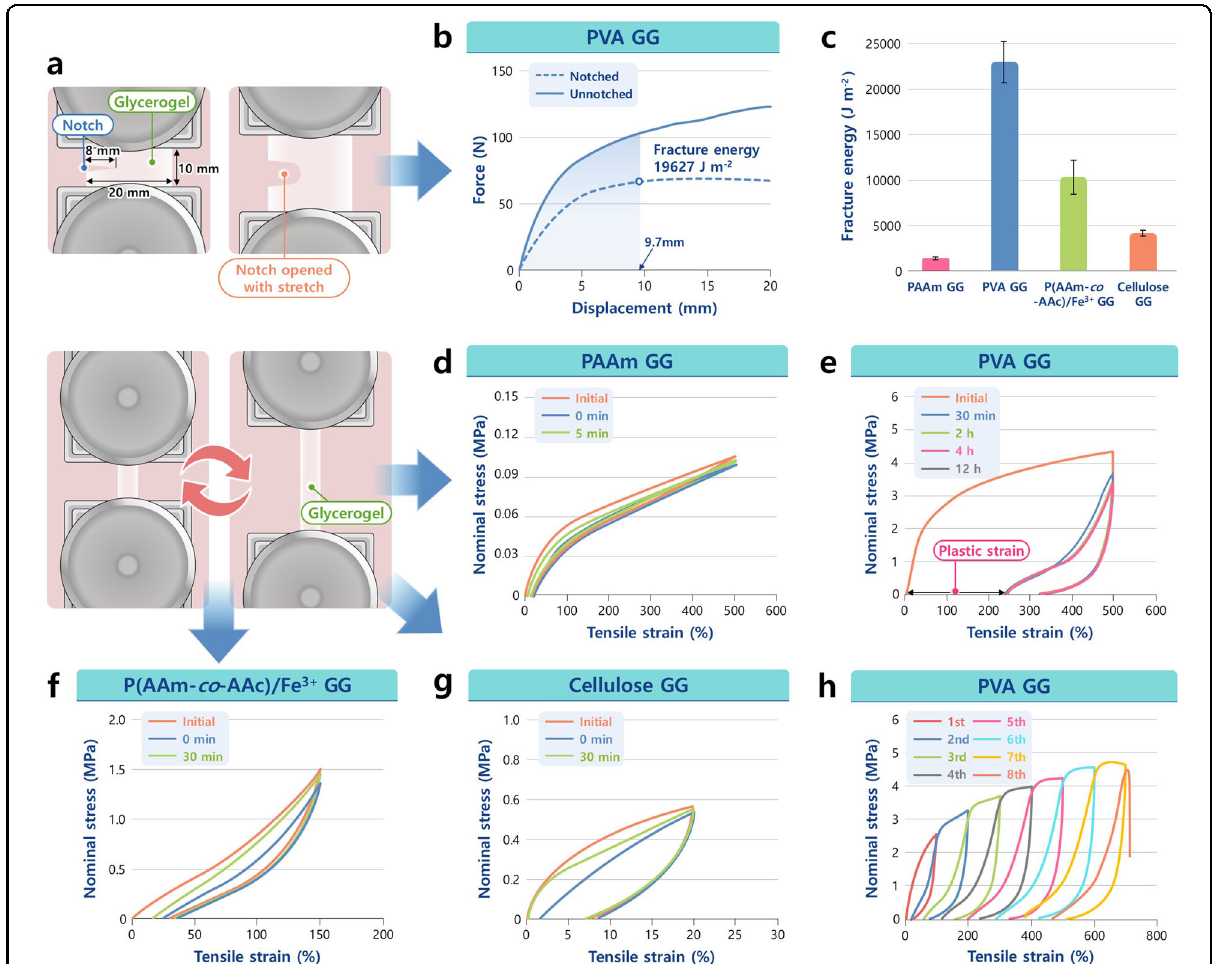
Fig. 4 Fracture toughness, hysteresis, elasticity, and plasticity of the GGs. a Demonstration of the tensile fracture test of the notched sample for the determination of fracture energy. b Force vs. displacement curves of the notched and unnotched samples of PVA GG. The critical displacement ( L c ) at which cracks begin propagating through the notched sample (detected by video analyses) is identi fi ed by the open circle. The fracture energy is determined by dividing the work done ( fi lled area) to stretch the unnotched sample to L c by the cross-sectional area of the sample. c Determined fracture energies of different GGs. Tensile loading – unloading curves of ( d ) PAAm GG, ( e ) PVA GG, ( f ) P(AAm- co -AAc)/Fe 3 + , and ( g ) cellulose GGs at different waiting times. ( h ) Tensile loading – unloading curves of the PVA GG with periodic enhancement in strain by 100% to its fracture